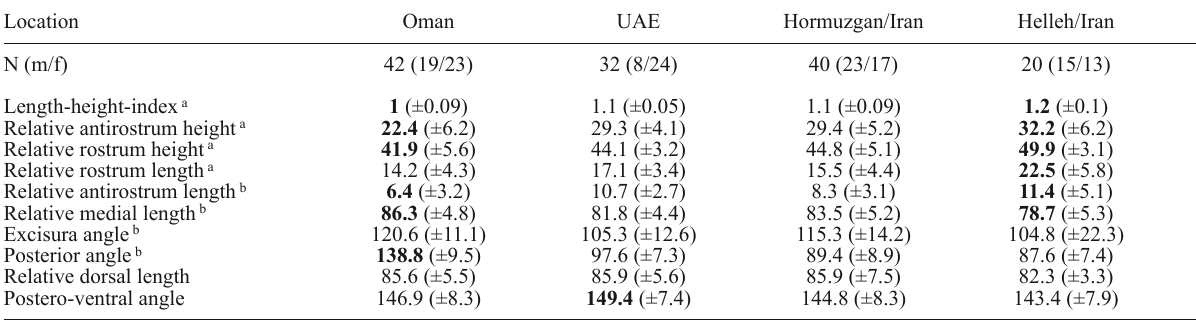
Table 1. – Values of otolith variables (means and standard deviations) of the studied Aphanius dispar populations (one-way ANOVA with Duncan Post-hoc test, P <0.05); significantly different values of variables are highlighted in bold; N , number of individuals; m, males; f, females; UAE, United Arab Emirates.